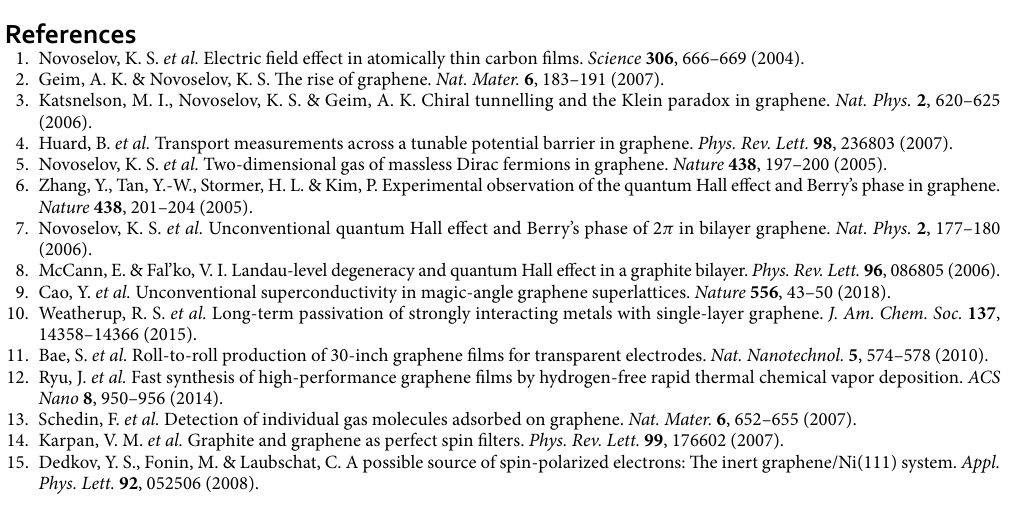
Figure 4. Simulated STM images of graphene/ Cu 2 Mn/Cu(111)—model B ( a ) for occupied E F 100 meV) and ( b ) unoccupied ( E ( E − = − to a tunneling current of 1.2 nA 46 . The STM pictures are overlaid with the crystallographic structure of the studied